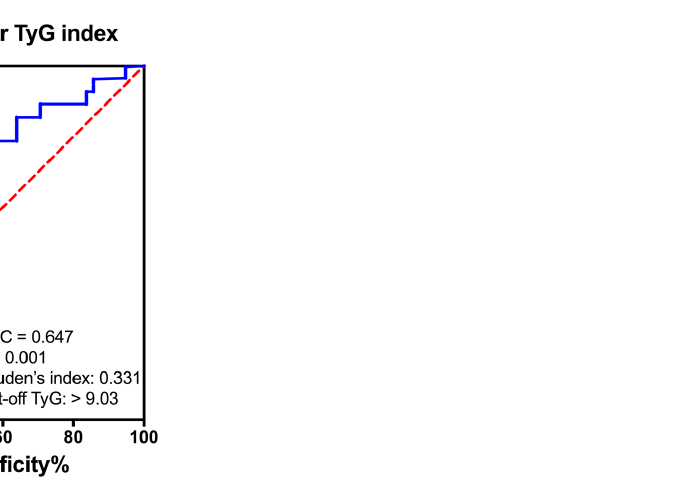
Table 3. Logistic regression analyses showing the predictive value of TyG index for VDD prevalence.